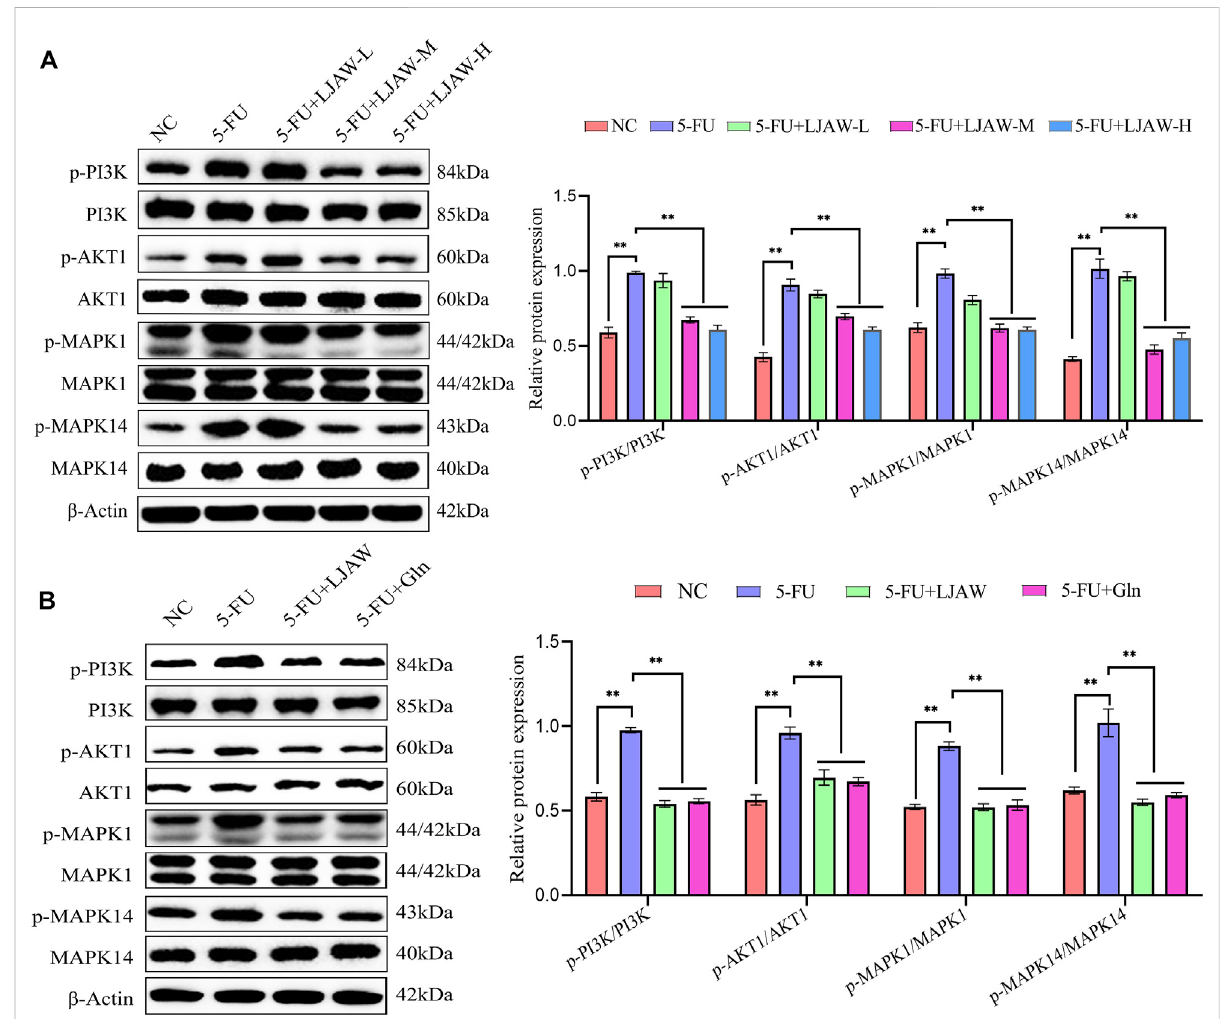
FIGURE 8 (A) EffectofLJAWontheratiosofp-PI3K/PI3K,p-AKT1/AKT1,p-MAPK1/MAPK1,andp-MAPK14/MAPK14insmallintestine (B) EffectofLJAWon the ratios of p-PI3K/PI3K, p-AKT1/AKT, p-MAPK1/MAPK, and p-MAPK14/MAPK14 in organoids. Data are expressed as means ± SD (n = 3). ** p < 0.01 compared with the 5-FU